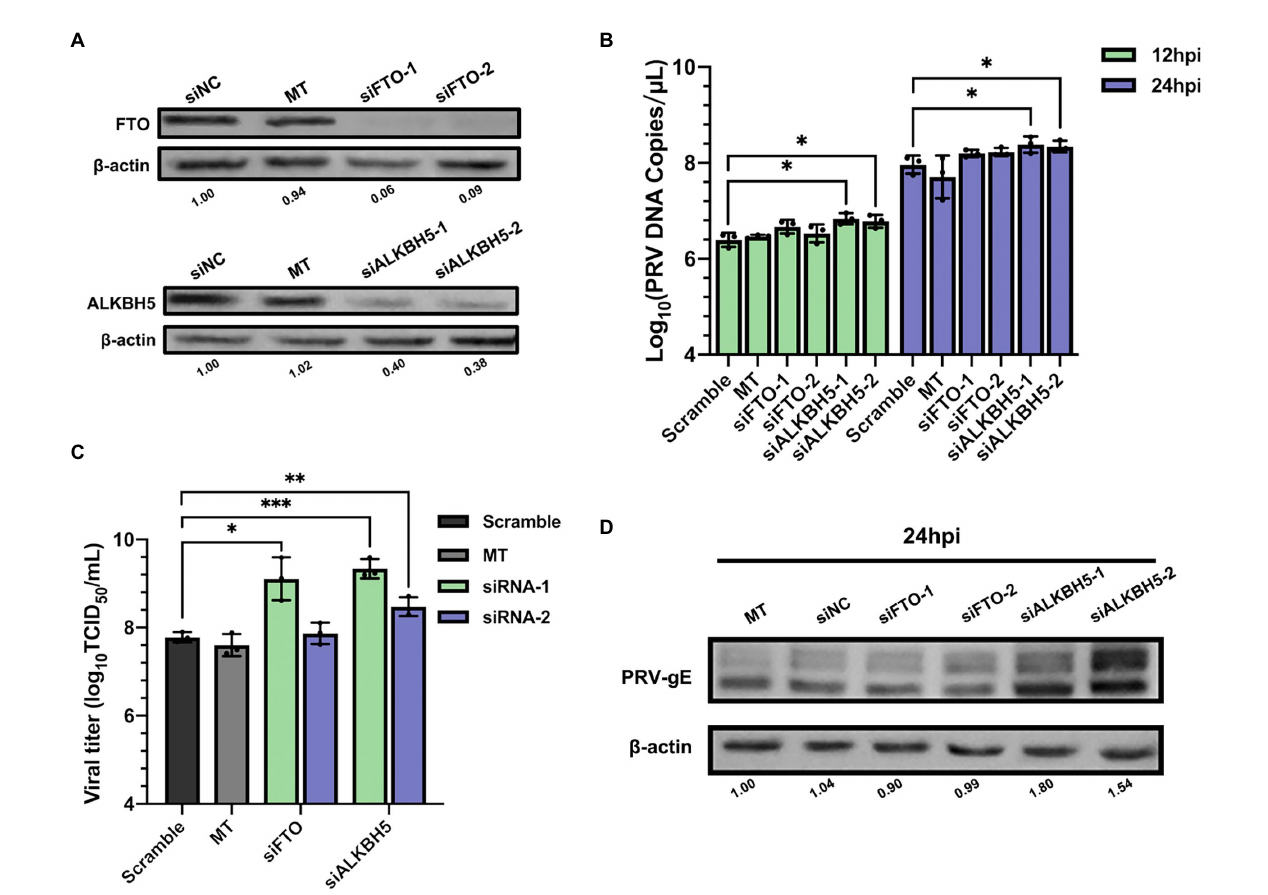
FIGURE 6 Demethylase FTO and ALKBH5 promoted PRV proliferation. (A) PK15 cells were transfected with the specified siRNAs (60 nM) for 24 h. FTO and ALKBH5 were assessed by immunoblotting analysis. β -actin was used as a loading control. (B) PK15 cells were transfected with the specified siRNAs and were mock transfected (MT) with transfection reagent alone for 24 h. PK15 cells were infected with PRV-FJ01 (MOI = 0.1) for 12 and 24 h. PRV DNA copies were evaluated by RT-qPCR analysis. (C) PK15 cells were transfected with the indicated siRNAs and were mock transfected (MT) with transfection reagent alone for 24 h. PK15 cells were infected with PRV-FJ01 (MOI = 0.1) for 24 h. PRV titers were assessed by TCID 50 analysis. (D) PK15 cells were transfected with the indicated siRNAs and were mock transfected (MT) with transfection reagent alone for 24 h. PK15 cells were infected with PRV-FJ01 (MOI = 0.1) for 24 h. PRV gE was assessed by immunoblotting analysis. β -actin was used as a loading control. * p < 0.05, ** p < 0.01, *** p <